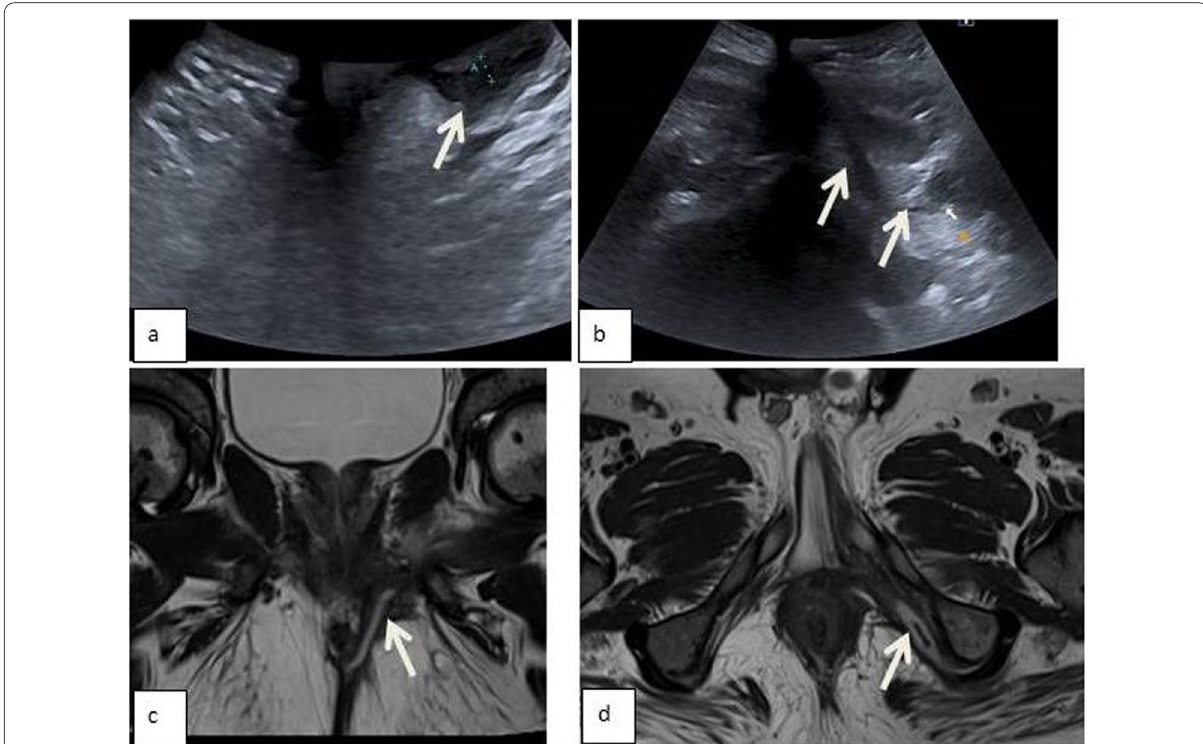
Fig. 5 a 29‑year‑old male patient, with history of recurrent perianal fistula. TPUS in axial plane ( a ) shows a left‑sided trans‑sphincteric perianal tract, breaching the distal part of the deep external anal sphincter, crossing the left ischio‑anal fossa. On coronal ultrasound images ( b ), the proximal extension of the left‑sided tract could not be detected. In T2 oblique coronal image ( c ), the left trans‑sphincteric tract is seen crossing the left ischio‑anal fossa. In T2 oblique axial image ( d ), it was noted that it forms an intra‑muscular abscess involving the left obturator internus